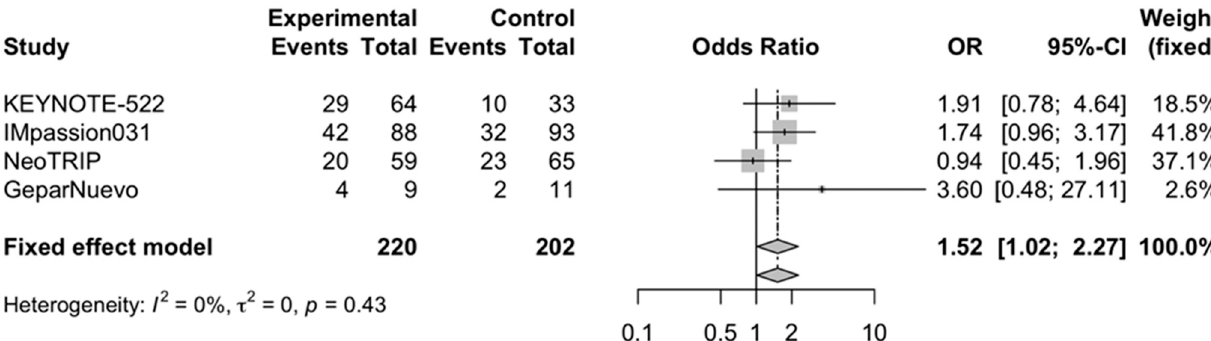
was pathological complete response (pCR) rate in PD-L1 positive patients. Abbreviations: OR—